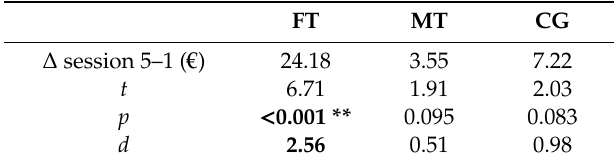
Table 2. Statistics for one-sample t -tests within groups (the last session compared to the first session) for overall IGT gains.